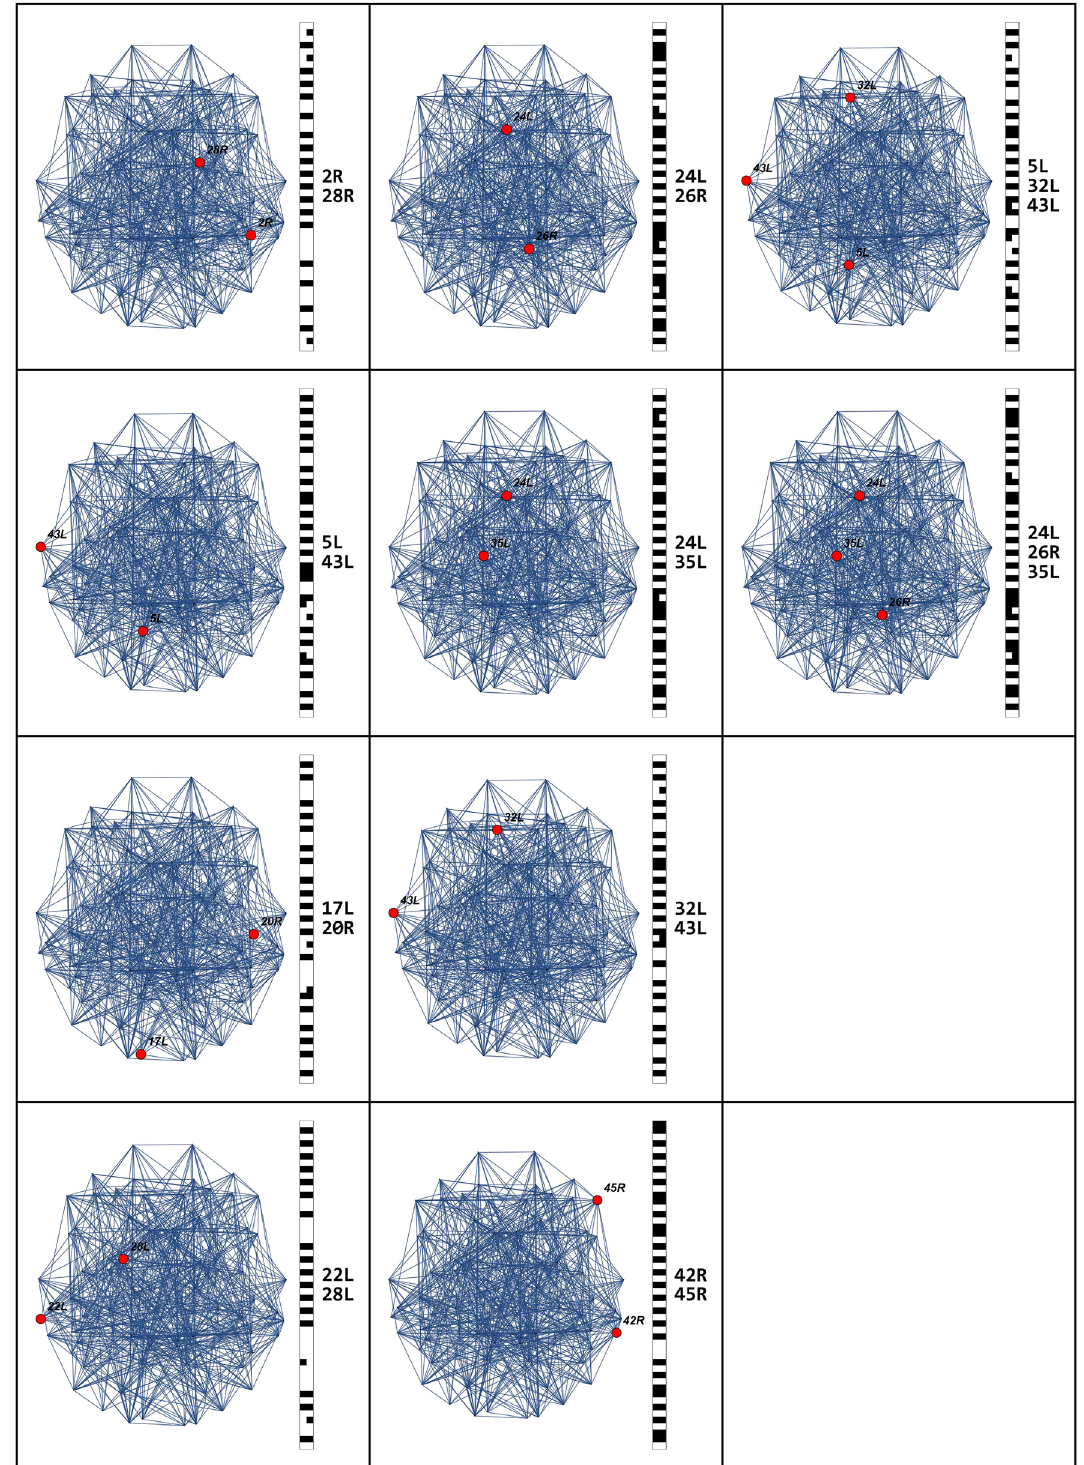
Figure 8. Representation of the emerged circuits in the brain connectome, setting the threshold parameter of connection among nodes at